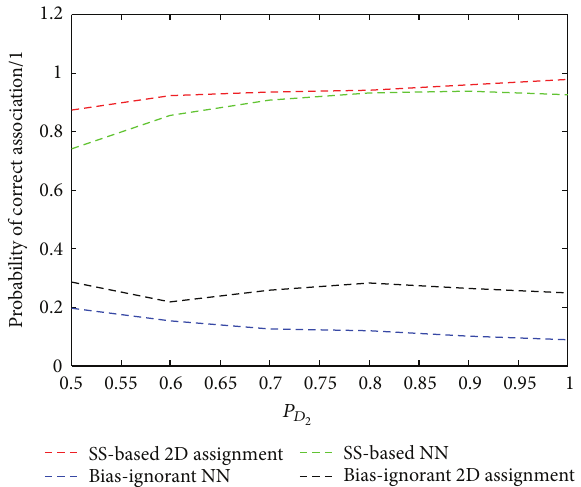
Figure 9: Average probability of correct association via different range biases.